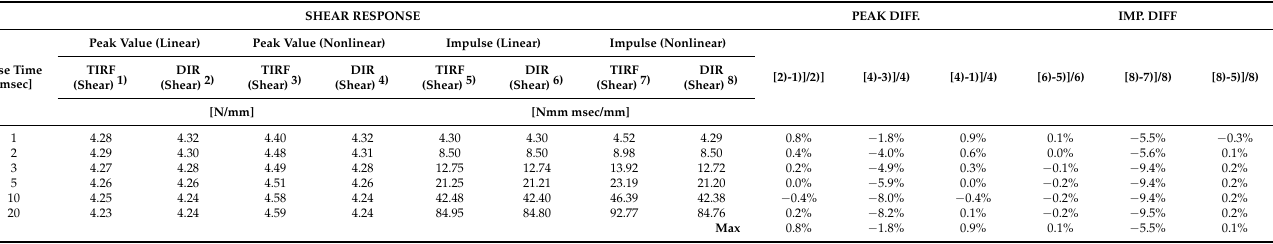
Note: IMP. = impulse value, DIFF = difference. Table 5. Bending responses for steel boxes (Model